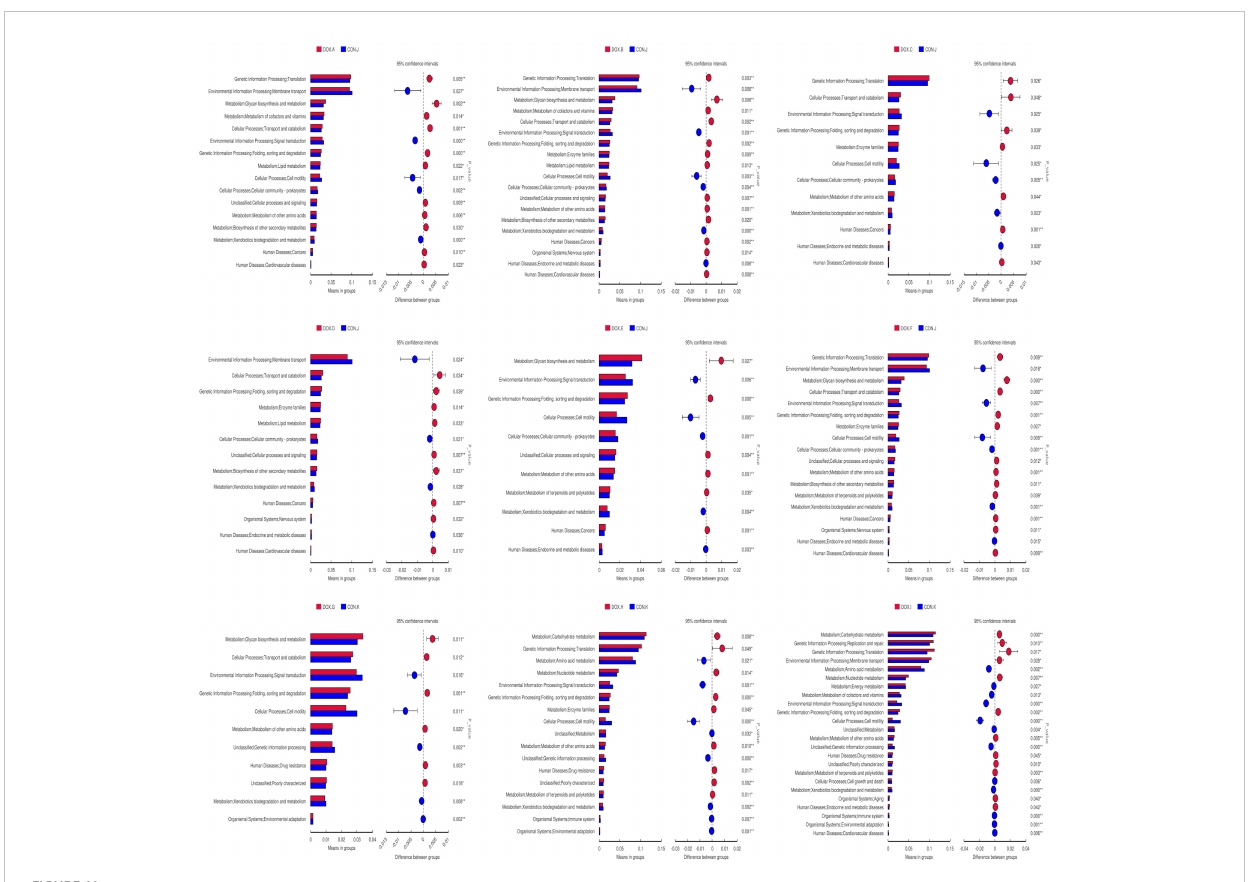
FIGURE 11 Predicated function of the gut microbiota based on Tax4Fun level 2 Differential metabolic pathway in CON group and DOX group. CON, control; DOX,